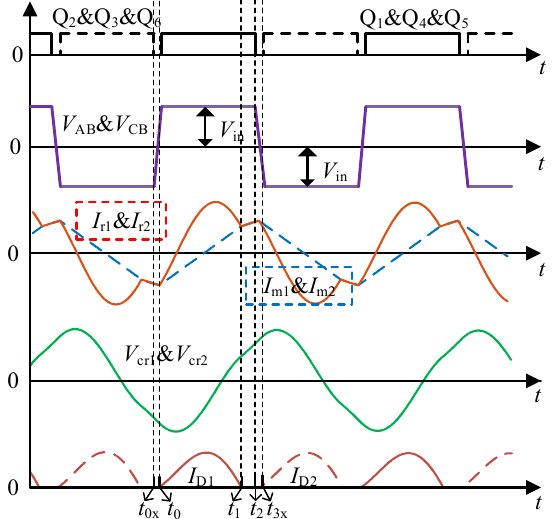
Figure 4. Main working waveform diagram of full-bridge FM mode.